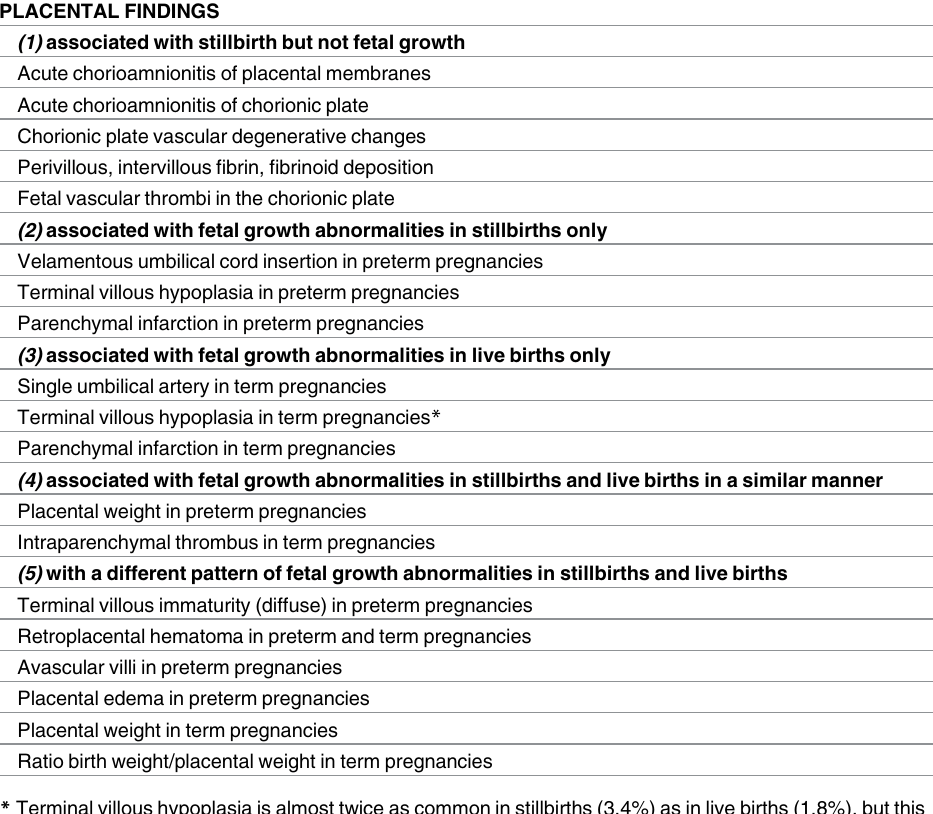
Table 4. Patterns of association between placental findings, fetal growth and stillbirth. PLACENTAL